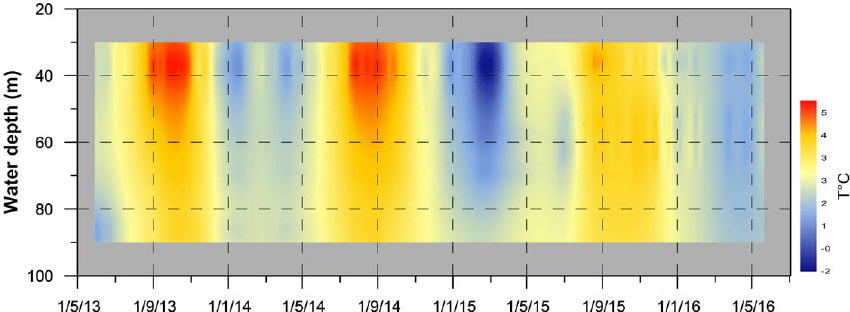
Figure 7. Temporal variability in the water temperature section, reconstructed between May 2013 and June 2016 based on measurements at four levels (36–37m, 54–58m, 62–69m,